Question: Sum up the contents of this chart in one sentence.
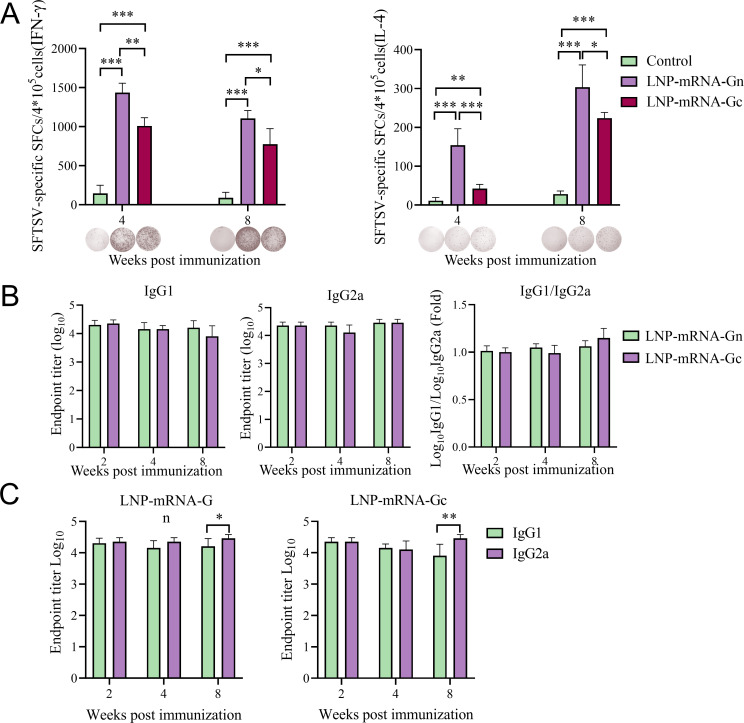
Answer: Activation of the Th1/Th2-mediated immune response after LNP-mRNA-Gn/Gc immunization. ( A ) Inactivated purified SFTSV virion-specific IFN-γ + SFCs and IL-4 + SFCs were detected via ELISpot kits (eight wild-type mice per group; four mice per group per time point; values are means ± SEM; ANOVA with Tukey’s multiple comparisons test). ( B, C ) The relative ratios of SFTSV-specific IgG1, IgG2a, and IgG1/IgG2a in LNP-mRNA-Gn- and LNP-mRNA-Gc-immunized mice (18 wild-type mice per group; 6 mice per group per time point; values are means ± SEM; Student’s t -test). * P < 0.05, ** P < 0.01 and *** P < 0.001.